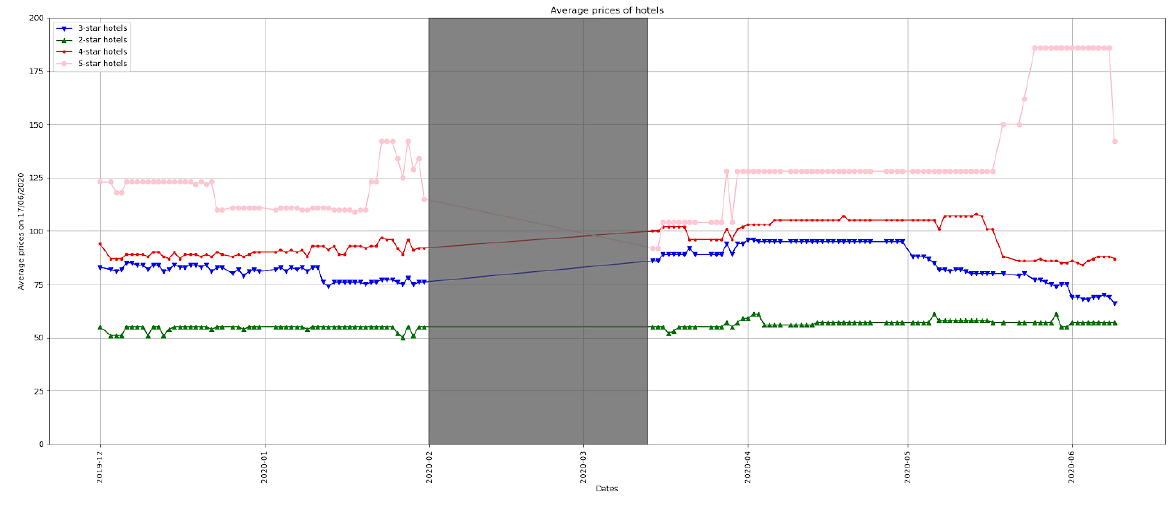
Figure 7. Average prices of